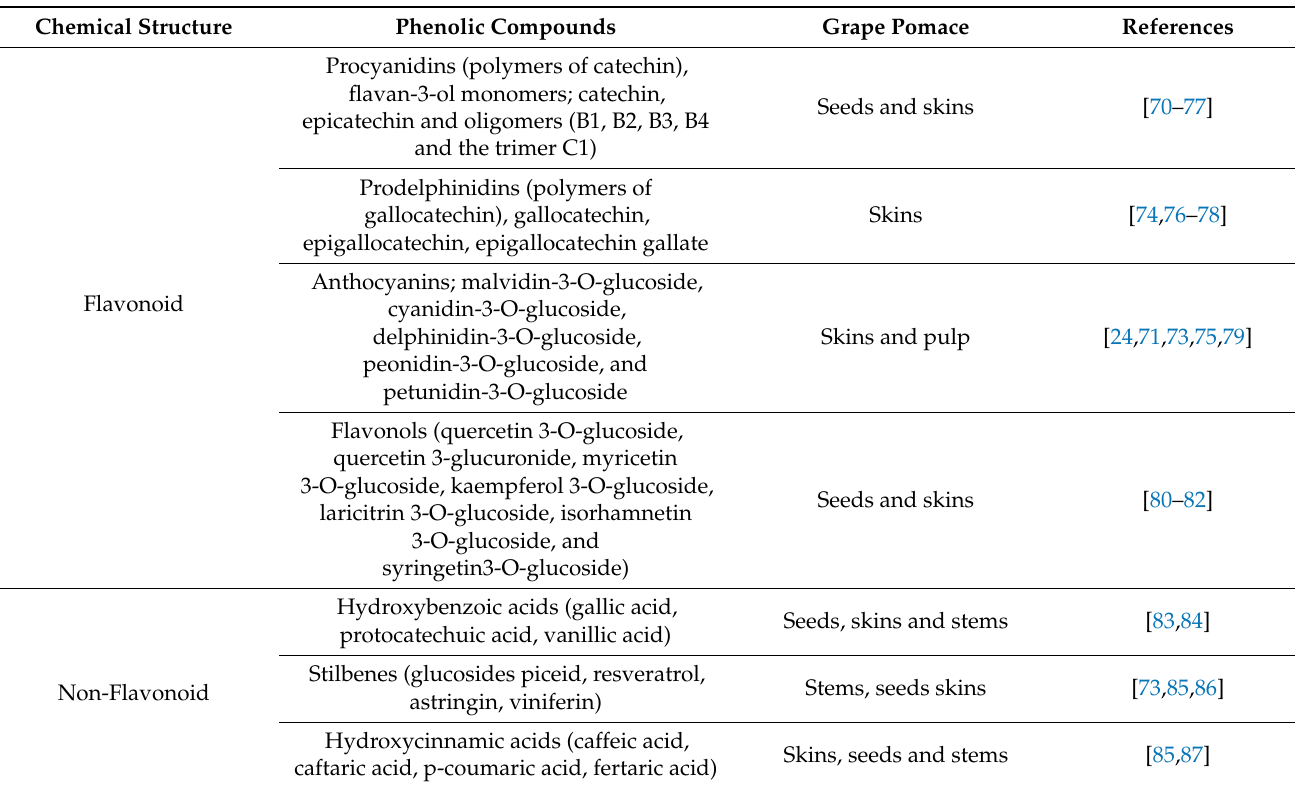
Figure 3. Wine by-product bioactivity showed by pre-clinical and clinical trials. Table 1. Summarized list of the most relevant phenolic compounds in the parts that make up Grape Pomace (skins, seeds,